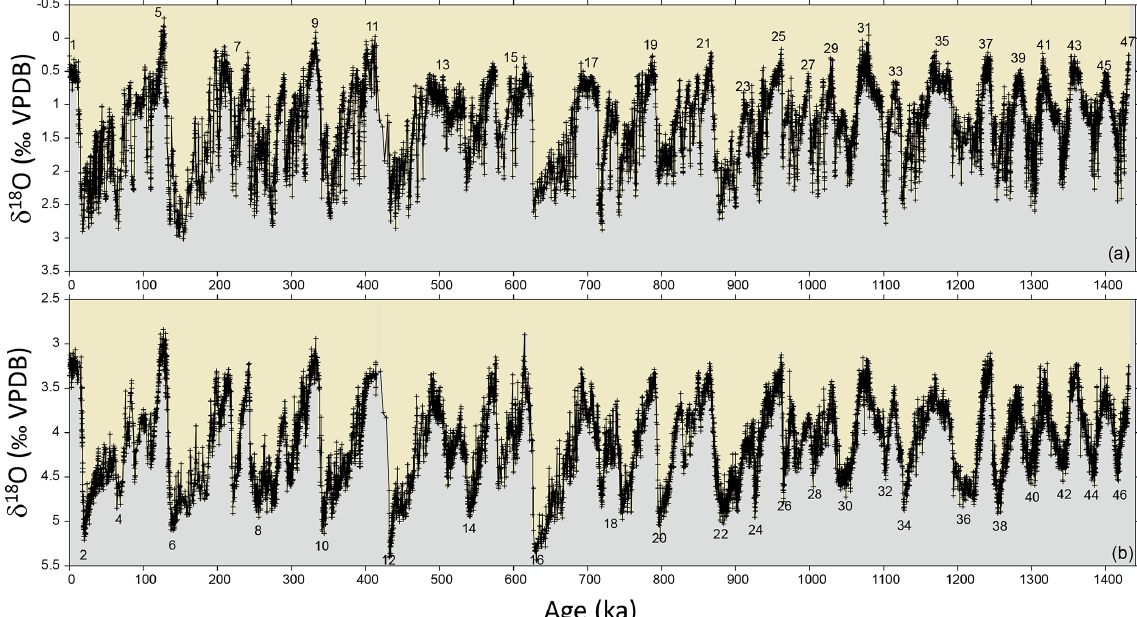
Figure 3. δ 18 O (per mil, Vienna Pee Dee Belemnite (VPDB)) of the planktic foraminifer Globigerina bulloides (a) and mixed benthic foraminifera, mainly Cibicidoides wuellerstorfi , corrected to Uvigerina (b) , at IODP Site U1385. Interglacial Marine Isotope Stages (MIS) are labelled with odd-numbered interglacials in (a) and even-numbered glacial stages in (b) .